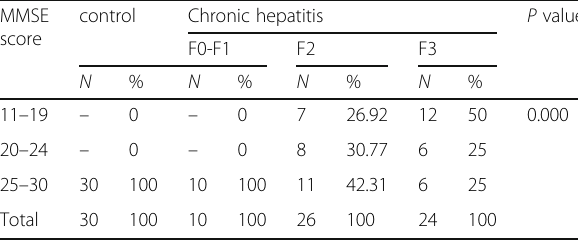
Table 2 Distribution of MMSE scores among the studied